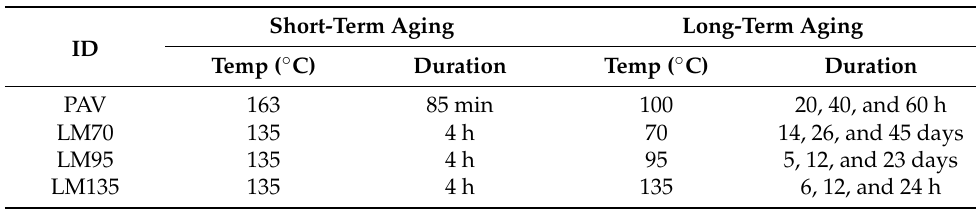
Table 3. Laboratory aging conditions.